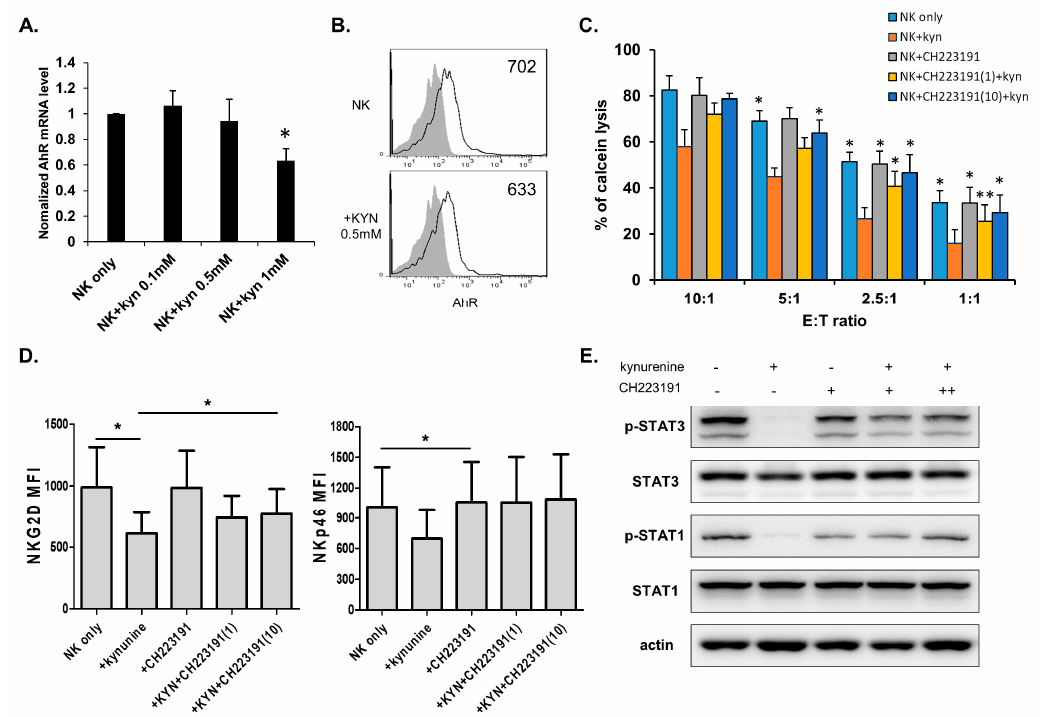
Figure 4. Kynurenine inhibits NK cell activity through aryl hydrocarbon receptor (AhR). mRNA level ( A ) and surface expression ( B ) of AhR were analyzed in kynurenine-treated or untreated NK cells. ( C ) NK cells were cultured with IL-2 in the absence (blue) or presence of indicated component for 24 h and cytotoxicity against K562 cells was examined; L-kynurenine (orange), CH223191(gray), kynurenine with CH223191 (yellow and dark blue). Bars represent mean ± SD of three independent experiments. ( D ) Expressions of NK receptors, NKG2D, and NKp46 were analyzed by flow cytometry. Graphs represent mean values of MFI for three independent experiments of receptors. ( E ) Phosphorylation of STAT-3 and 1 signals were examined by Western blotting in NK cells under the indicated conditions. β -actin served as a loading control. Statistical analyses were performed using the paired two-tailed Student’s t -test. * P < 0.05 and ** P < 0.01. 3.5. STATs Regulate NK Cytolytic Activity and Receptor